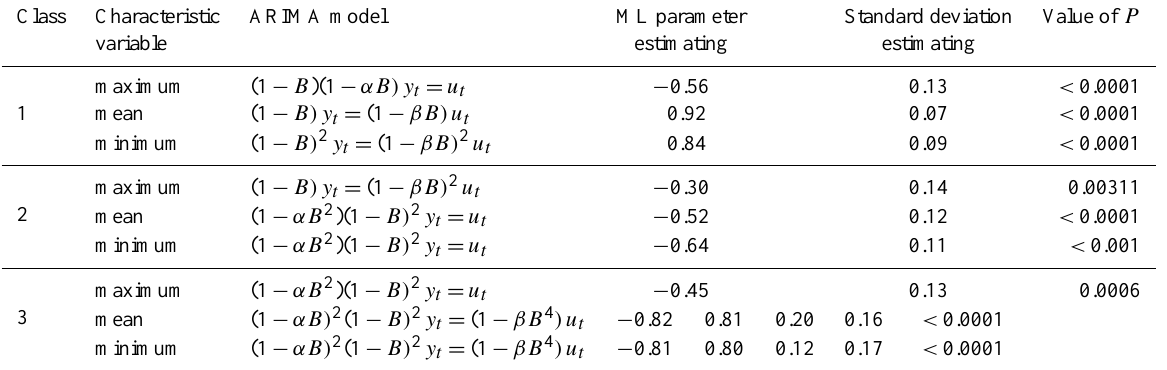
Table 5. Parameters of ARIMA models for characteristic variables of each class.